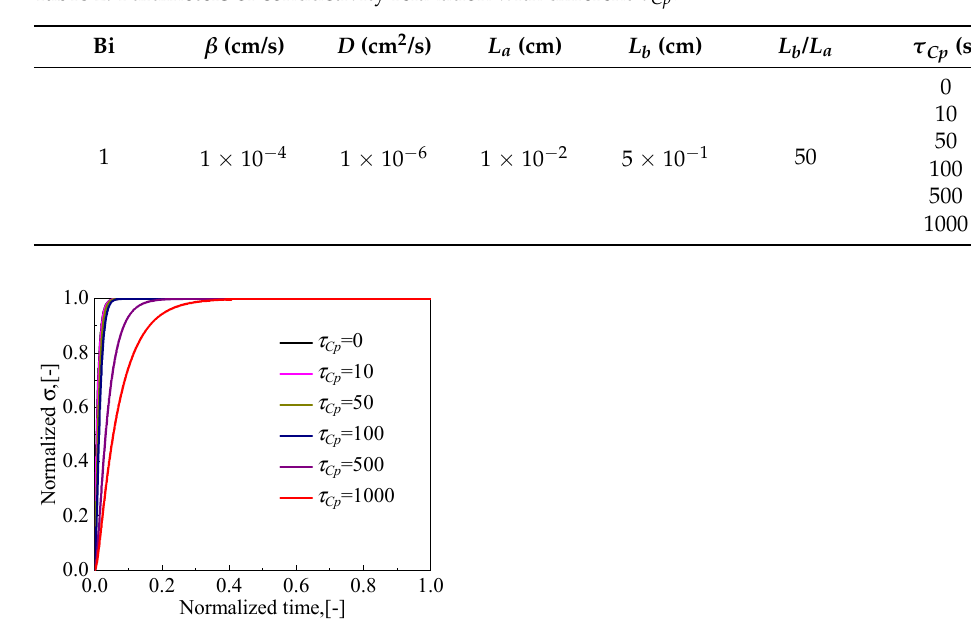
Table 2. Parameters of conductivity relaxation with different τ Cp .